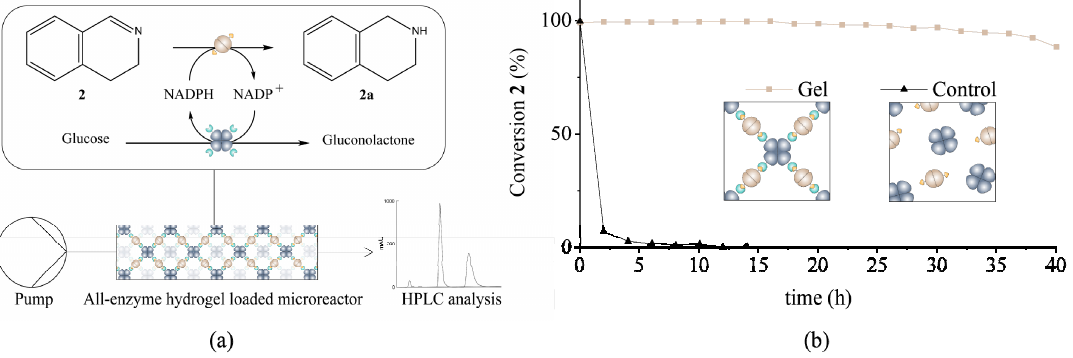
Figure 2. ( a ) Schematic representation of the microfluidic setup and cascade reaction in the microreactor. Imine 2 is reduced to the corresponding amine 2a by the GF3546-ST enzyme under consumption of nicotinamide adenine dinucleotide phosphate (NADPH). The cofactor is regenerated by the GDH-SC through oxidation of glucose to gluconolactone. ( b ) Time dependent conversion of imine 2 using the microreactor filled with the all-enzyme hydrogel (squares) or the control (triangles). Substrate and cofactor were added continuously at a concentration of 5 and 1 mM, respectively, at a flow rate of 10 µL/min.